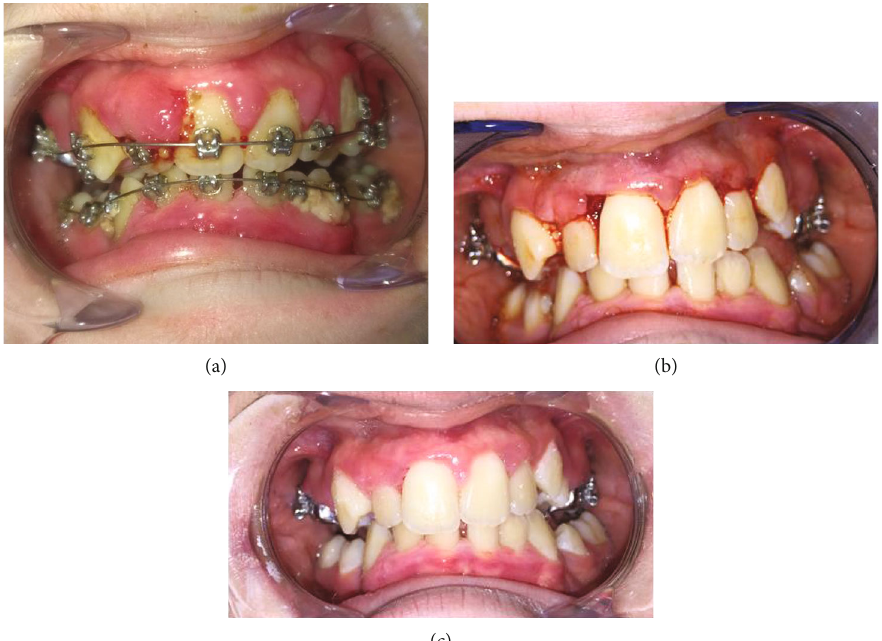
Figure 1: (a) Intraoral initial situation. (b) Intraoral situation after root planning and gingivectomy. (c) At 6 months, end of the fi rst phase of periodontal